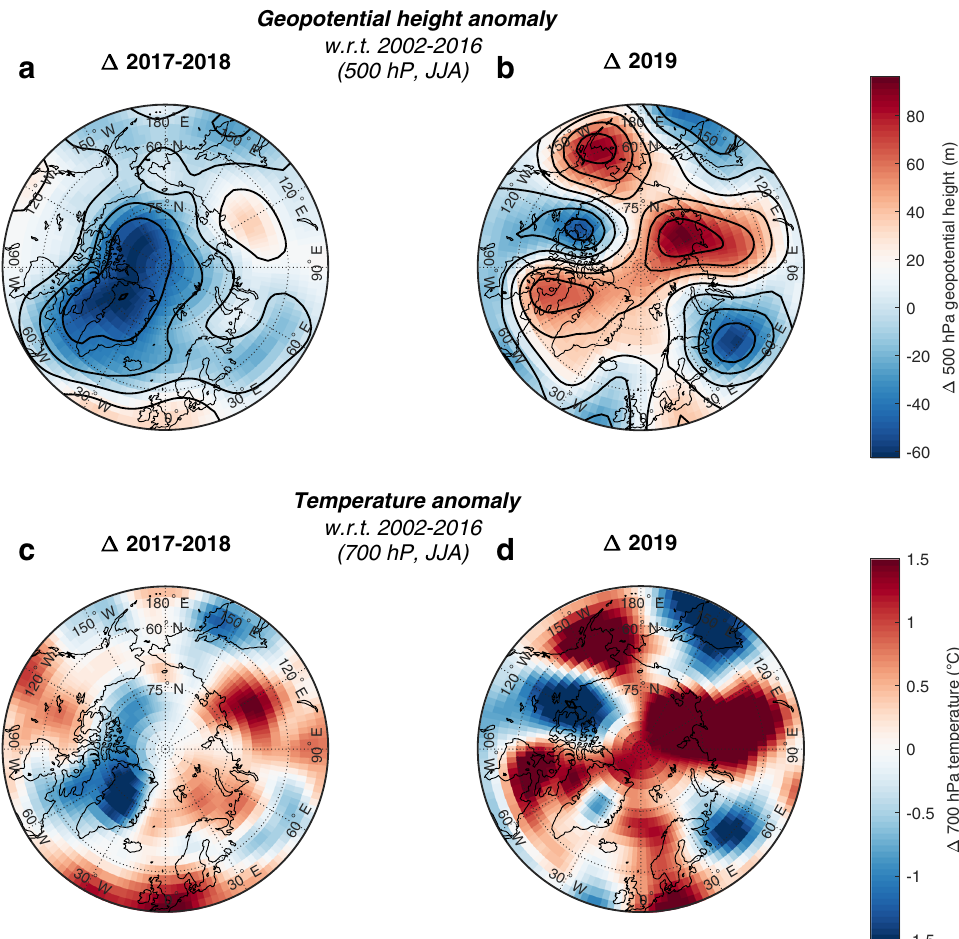
Fig. 4 Atmospheric conditions over the Arctic in summer for the low melt years of 2017 and 2018 and the strong melt year of 2019. Shown are summer mean (JJA) anomalies relative to 2002 – 2016. In 2017 and 2018, a 500 hPa geopotential height shows a pronounced low over Greenland, promoting below average (2002 – 2016), c temperatures at 700 hPa. In 2019, the pattern reversed with a higher, b 500 hPa geopotential height, accompanied by signi fi cantly warmer, d temperatures at 700 hPa in western Greenland. Thick black lines in a and b are contours of the anomaly of the 500 hPa geopotential height spaced at intervals of 20